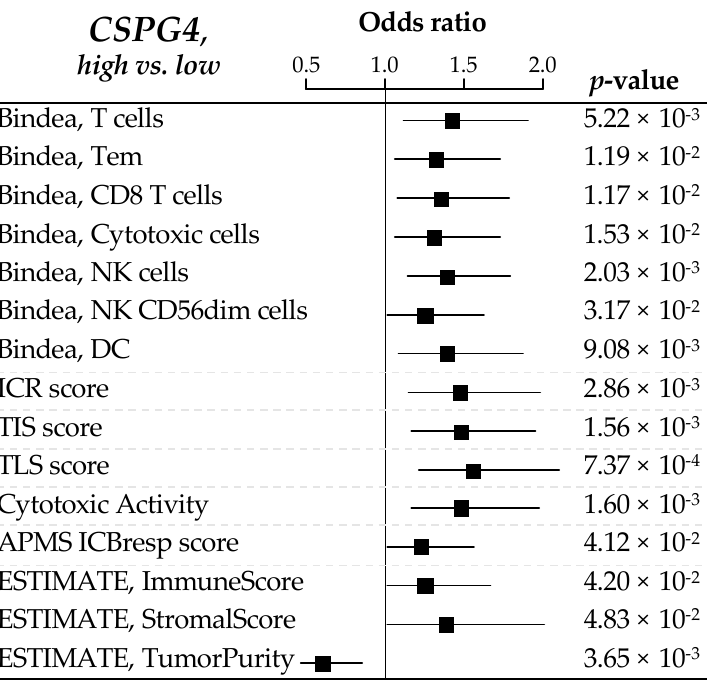
Figure 1. Disease-free survival in patients with localized GIST after surgery. ( A ) Kaplan-Meier DFS curves in the 87 informative patients for DFS. ( B ) Similar to ( A ), but according to CSPG4 expression (low and high). The p -value is for the log-rank test.